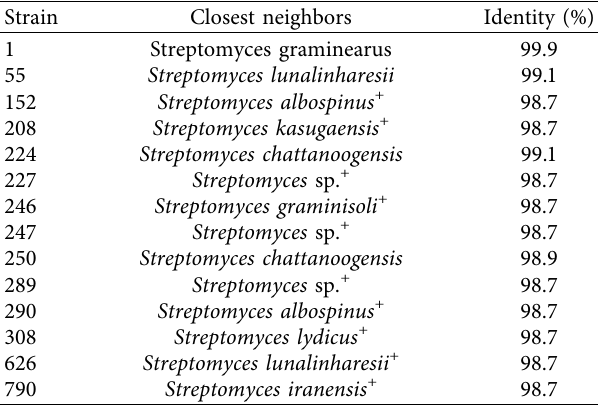
Table 4: Molecular identifcation of strains with PVC weight loss higher than